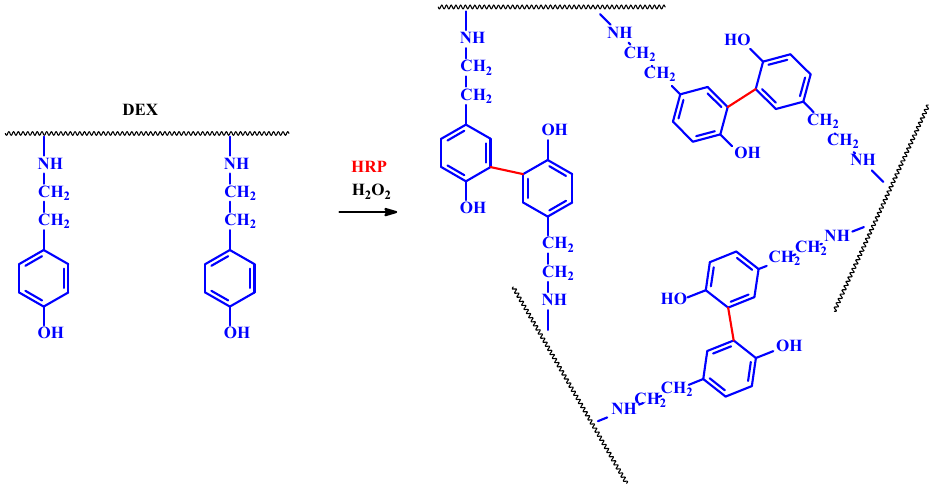
Figure 5. Enzymatic cross-linking of DEX–tyramine conjugates. A marine derived oxidized ALG, alginate dialdehyde (ADA), and Gel hydrogel sys- tems (ADA-Gel) have been obtained [29]. The systems have been cross-linked via Ca 2+ and microbial transglutaminase (mTG) interaction (Figure 6). It was possible to control the degradation behavior of the hydrogels to be stable for up to 30 days of incubation. The cytocompatibility of mTG cross-linked ADA-Gel was assessed using NIH-3T3 fibroblasts and ATDC-5 mouse teratocarcinoma cells. Both cell types showed highly increased cellular attachment on mTG cross-linked ADA-Gel in comparison to Ca 2+ cross-linked hydrogels [29].